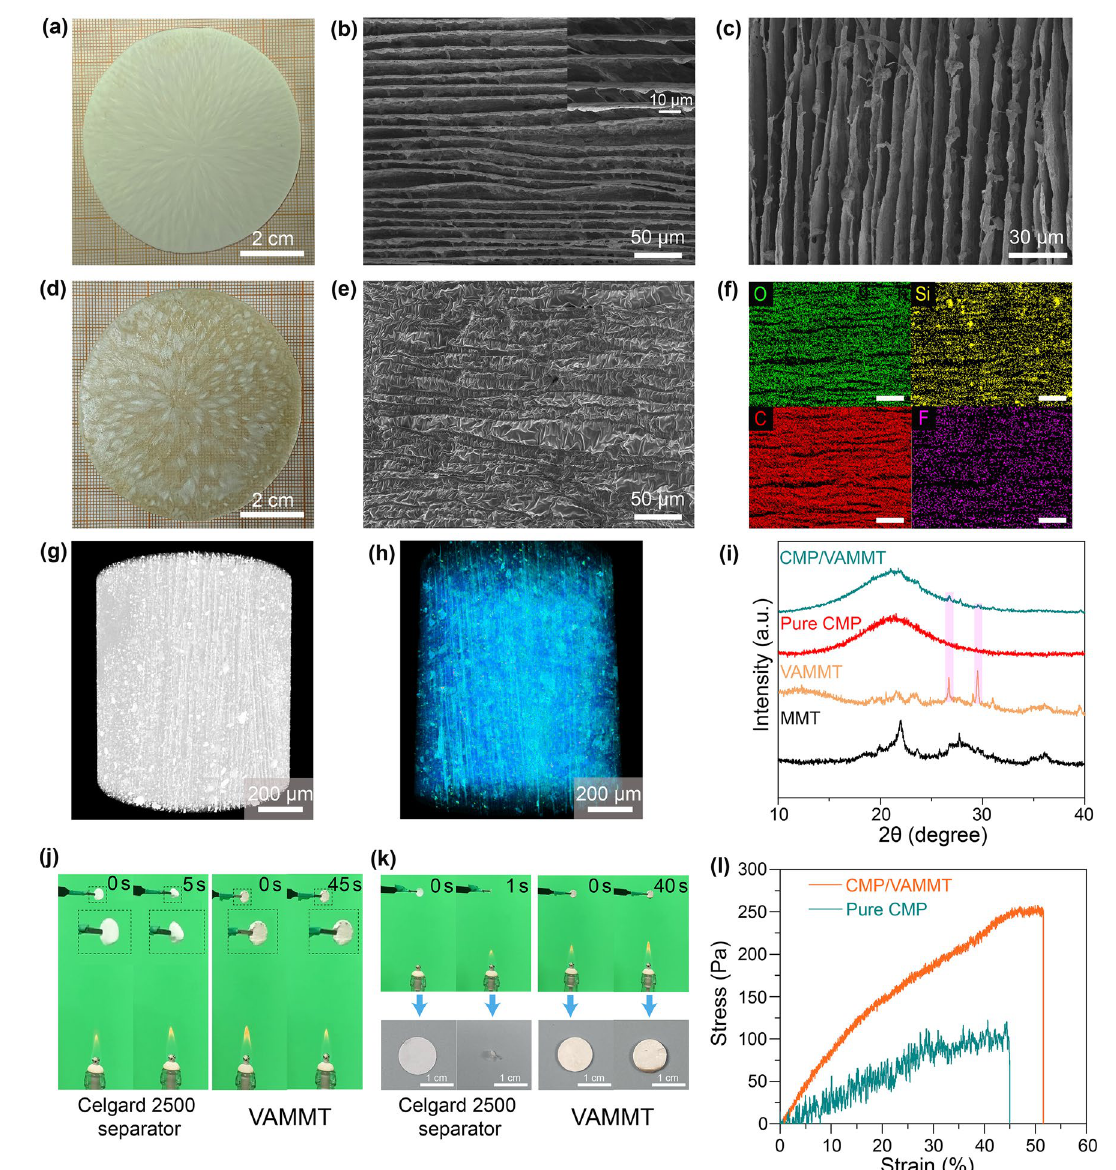
Fig. 2 Structure characterization of VAMMT and CMP/VAMMT. a Digital photograph of VAMMT. b SEM image (from top view) of VAMMT (the inset image shows the high magnification SEM image). c Cross-sectional SEM image of VAMMT. d Digital photograph of CMP/VAMMT. e , f SEM image (from top view) of CMP/VAMMT with corresponding element mapping of O, C, Si, F. The X-ray microscope image g before and h after CMP infiltration into VAMMT (blue aera represents gel matrix); i XRD patterns of CMP/VAMMT and its components; digital images of flame test on VAMMT and Celgard 2500 separator j far from the flame and k close to the flame; l stress–strain curves of different